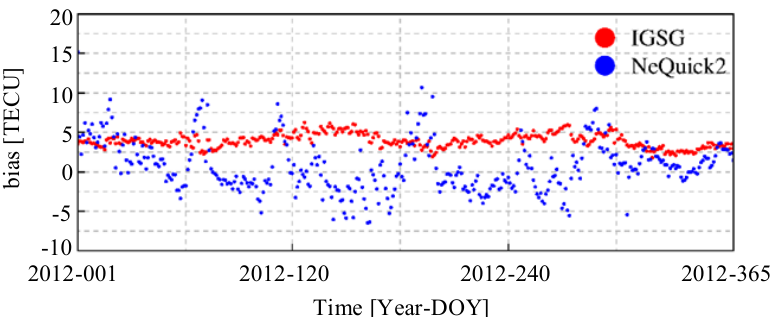
Figure 11. Daily average biases of IGSG and NeQuick2 with respect to Jason2 VTEC during the year 2012.